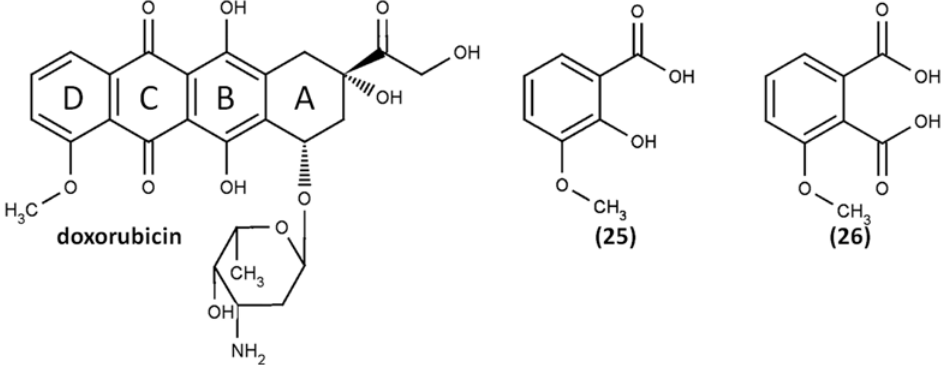
Figure 11. Doxorubicin and its oxidation products: 3-methoxysalicylic acid ( 25 ) and 3-methoxyphthalic acid ( 26 ) [131].